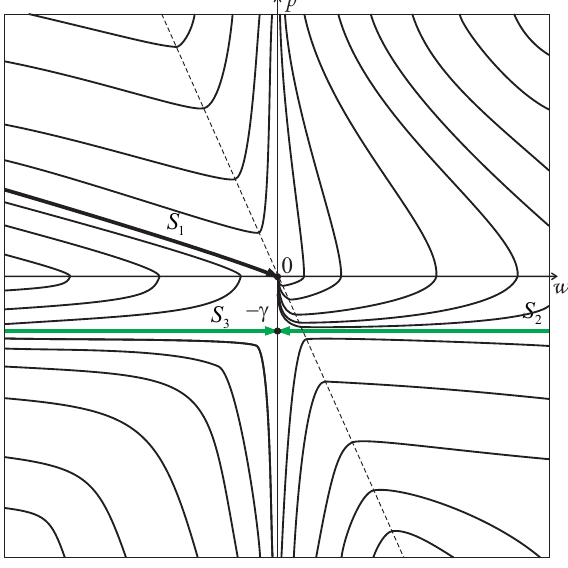
Figure 1. Phase portrait for γ = α